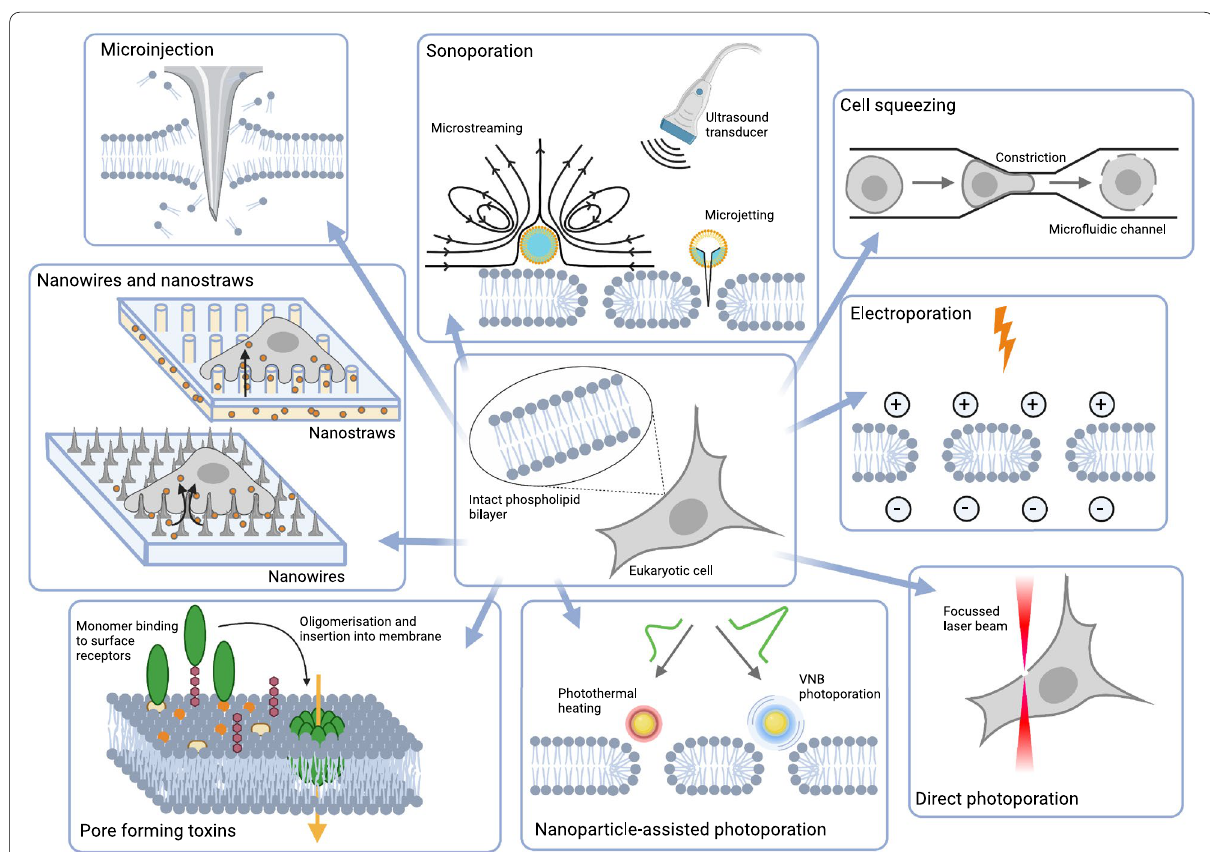
Fig. 1 An overview of the main techniques for PM disruption. Explanation of the individual techniques can be found in the main